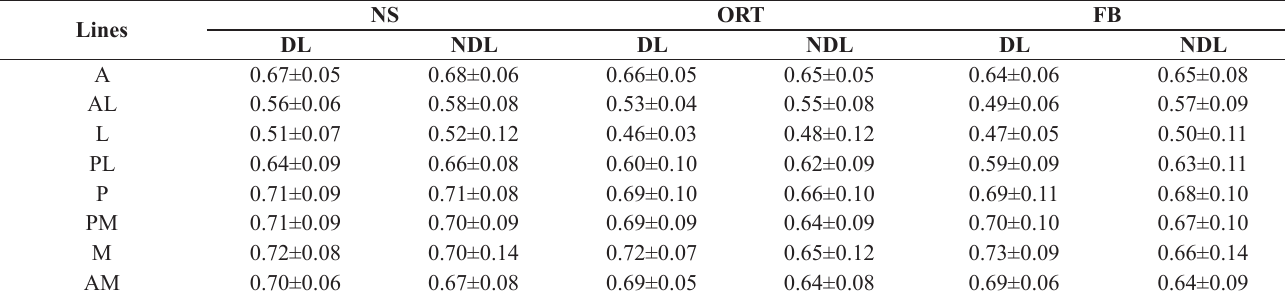
Table 1. Average values in SEBT, normalized by the length of the lower limb (%) of each participant. NS ORT FB Lines DL NDL DL NDL DL NDL A 0.67±0.05 0.68±0.06 0.66±0.05 0.65±0.05